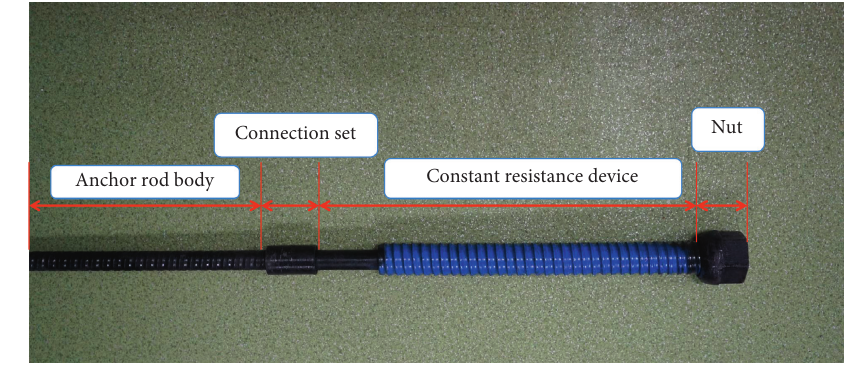
Figure 11: The structure of CRLDA [21].